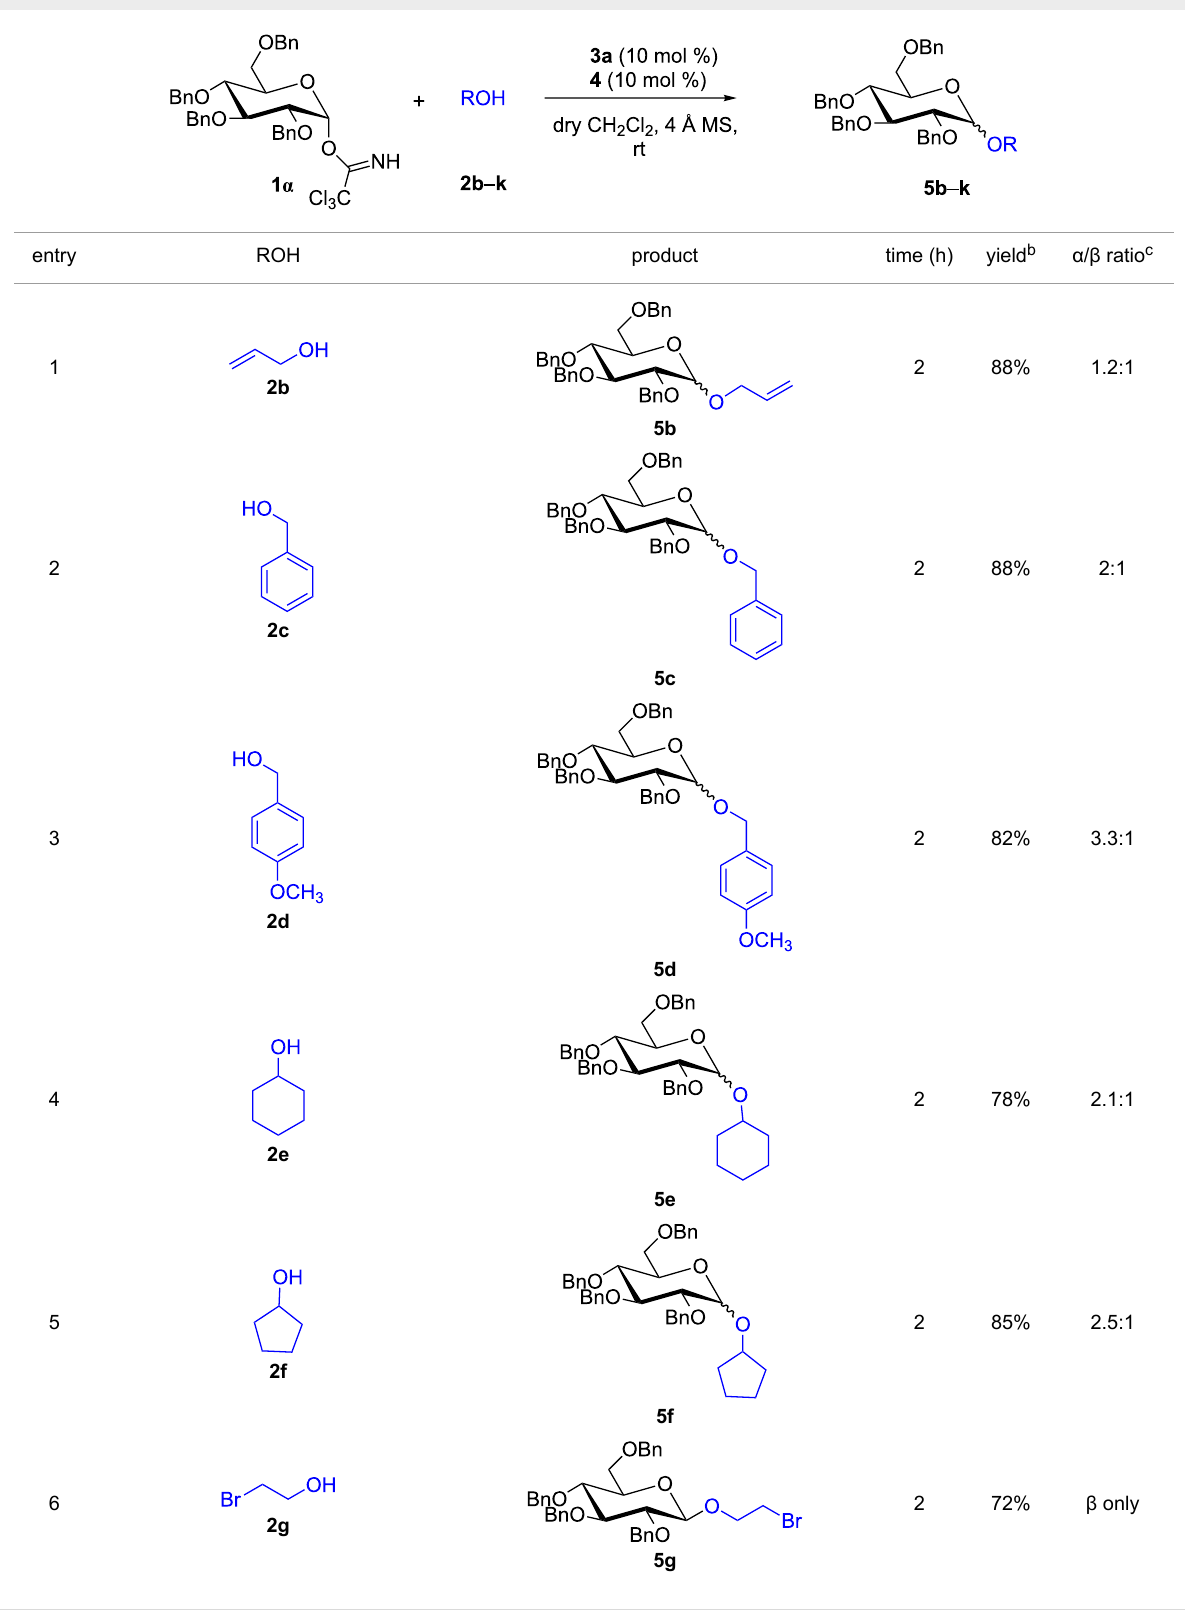
Table 2: Acceptor scope in glycosylation reaction with donor 1 α a